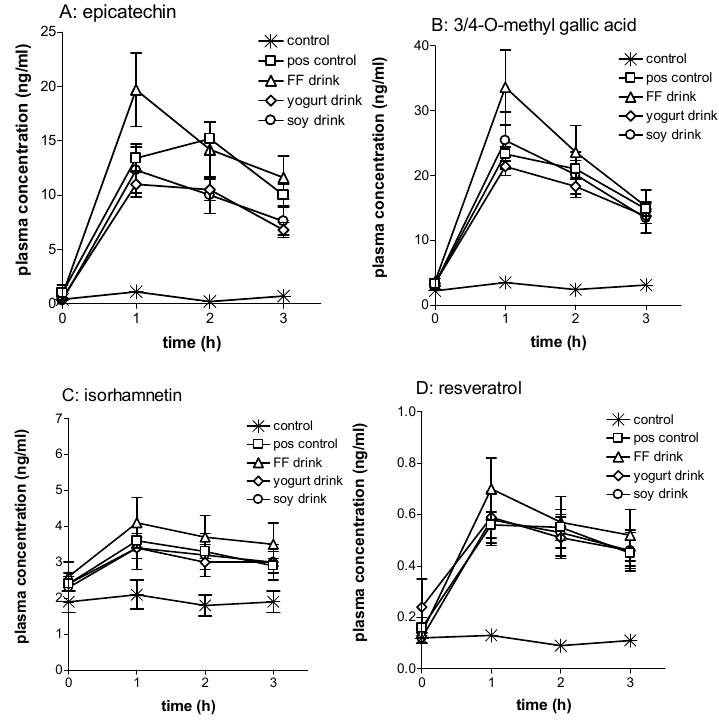
Figure 2. Plasma concentration (mean ± SEM, n = 32) versus time profiles for four individual polyphenols (including polyphenol ‐ conjugates) for the five different formulation treatments. ( A ) Epicatechin; ( B ) 3/4 ‐ O ‐ methyl gallic acid; ( C ) isorhamnetin; ( D ) resveratrol